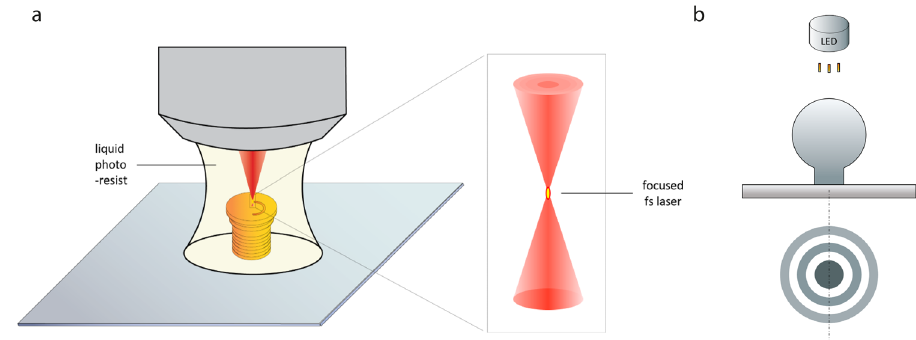
Fig. 1 Illustration demonstrating fi ducial fabrication and 3D focus locking. a Two-photon direct-laser writing. A NIR femtosecond laser is used to trigger a chemical reaction that causes polymerization of a photosensitive material. The nonlinear excitation solidi fi es the photo resin at the focal point, leaving other regions unaffected. b 3D focus locking. Under bright fi eld illumination the fi ducials create an interference pattern (below) which is recorded on a separate camera with high frame rate. Changes in the diffraction pattern are used to monitor the movement experienced by